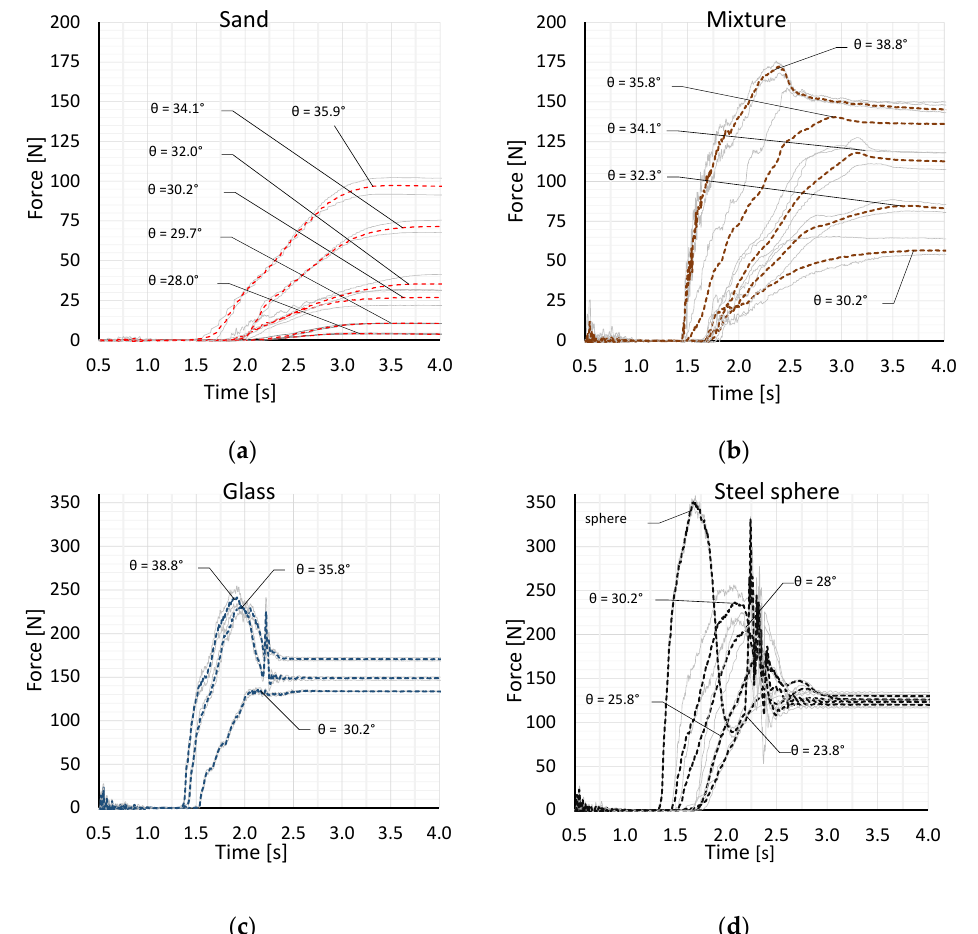
Figure 6. Impacts depending on the inclination of the flume base for the materials ( a ) sand, ( b ) mixture, ( c ) glass and ( d ) steel spheres on a rigid barrier.